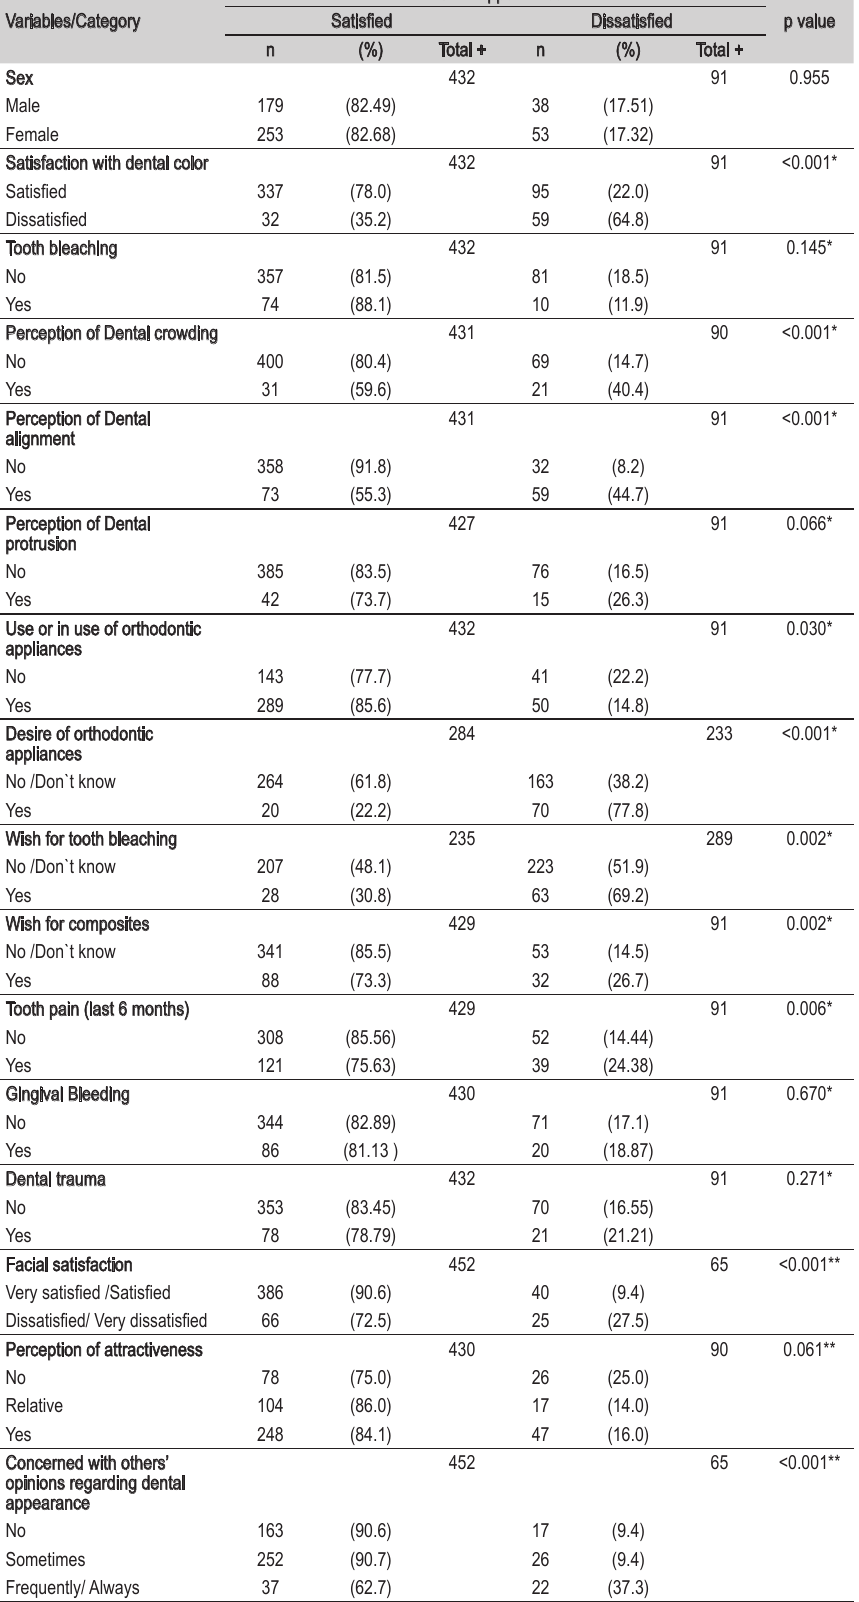
Table 2 - Bivariate analysis between satisfaction with dental appearance and